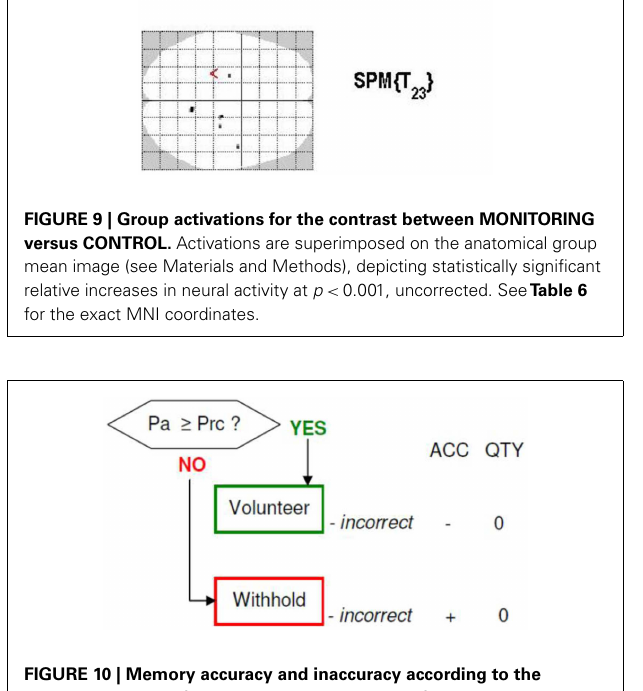
FIGURE 8 | Group activations for the contrast between CONTROL versus RETRIEVAL. Activations are superimposed on the anatomical group mean image (see Materials and Methods), depicting statistically significant relative increases in neural activity at p < 0.001, uncorrected. See Table 5 for the exact MNI coordinates.